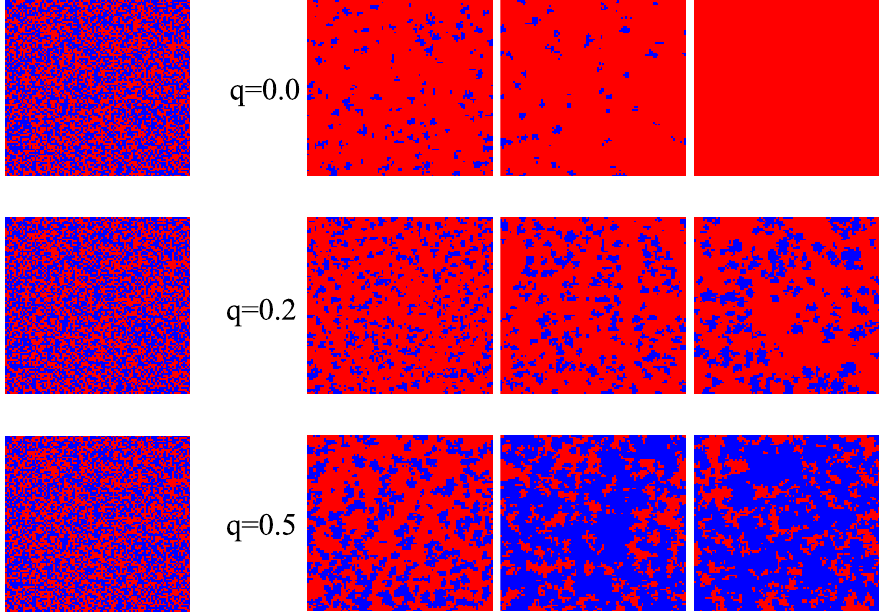
Figure 2. Characteristic snapshots of cooperators and defectors on the lattice for different values of information acquisition probability q . In the right area, from top to bottom, q is set to be 0 (traditional model), 0.2 and 0.5; from left to right, MCS step is set to be 10, 1000 and 10,000, respectively. For each case, the same temptation to defect T = 1.1 is applied here and the same initial state is assumed, where cooperators and defectors are randomly distributed with equal probability, as shown in the left area. In addition, the blue dots denote the defectors, while the dark red dots represent the cooperators. Other model parameters are fixed as: L = 100, K = 0.1, n = 12, c =